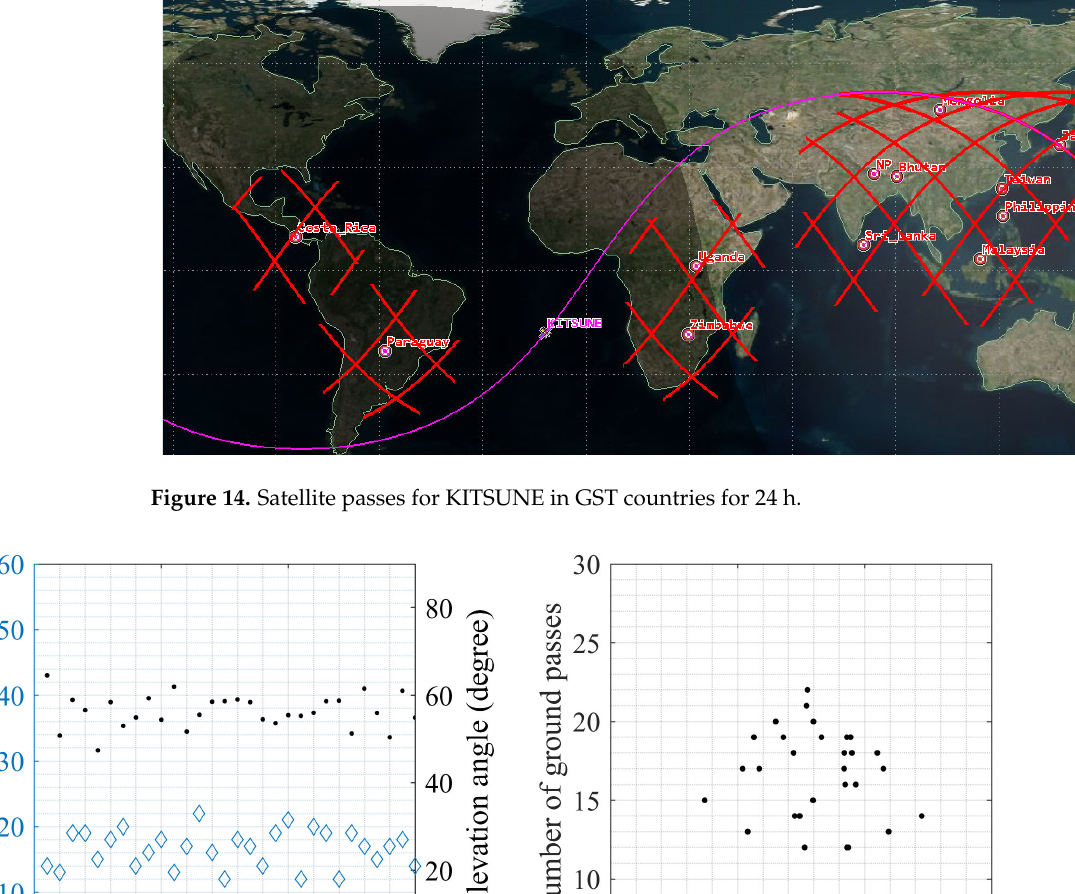
Figure 14. Satellite passes for KITSUNE in GST countries for 24 h.